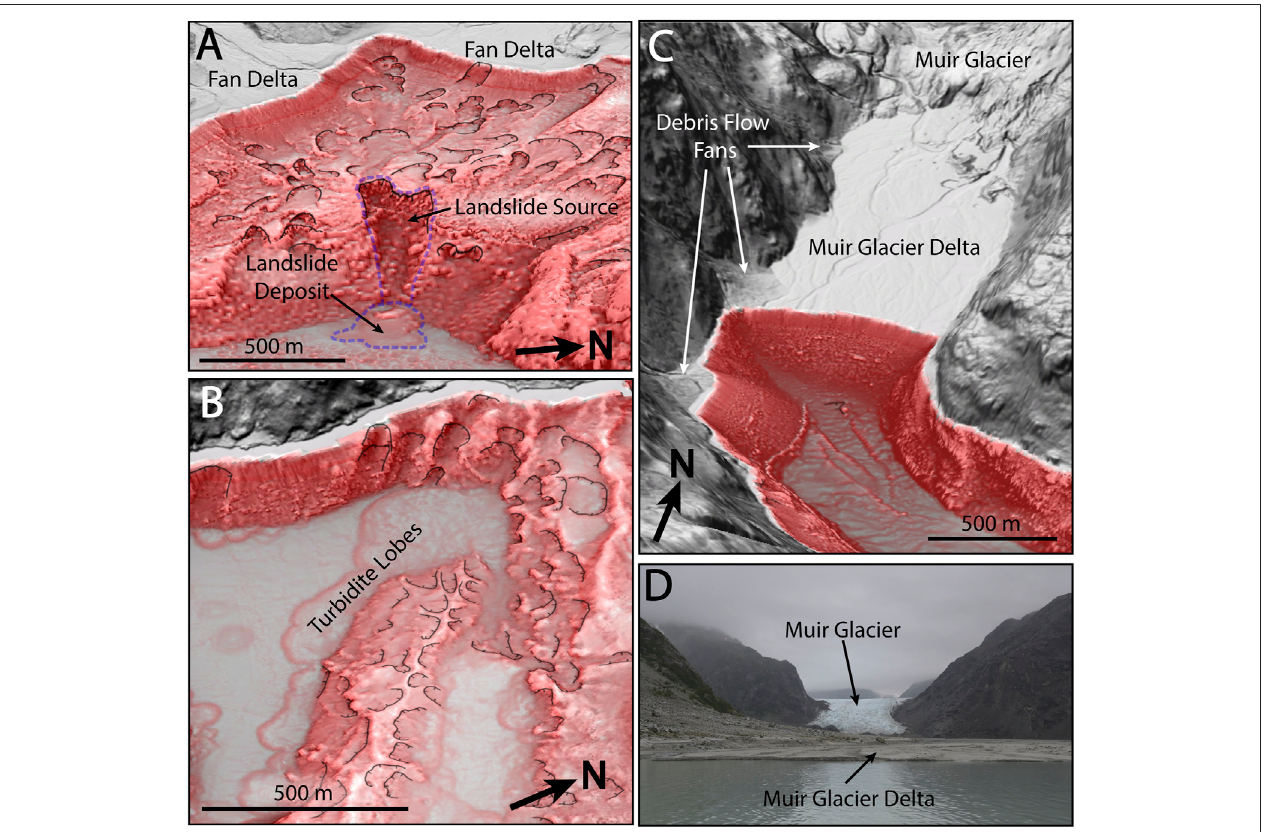
FIGURE5| ExamplesofmappedlandslidescarpsanddeltasinGlacierBay.Scalesareapproximate.See Figure3B forlocations.Scarpsaredelineatedwithblack lineswithhatch marks pointing down slope. (A) Oblique viewoflandslide with visiblescar and deposit (outlined indashed blue line) and shallow landslidescarpswithout visibledepositsonsedimentslopeabove.Approximatecenterofviewis136.120 ° W58.903 ° N. (B) Obliqueviewoflandslidescarpsinglacialmorainewithturbiditelobes on sea fl oor below. Turbidite deposits are approx. 1 – 3 m thick. Approximate center of view is 136.801 ° W 58.934 ° N. (C) Oblique view of the Muir Glacier and Delta with adjected debris fl ow fans and fan delta (bottom-most fan). Approximate center of view is 136.378 ° W 59.093 ° N. (D) Photograph taken on 25 August 2021, looking up the Muir Glacier Delta at Muir Glacier (view to the North).